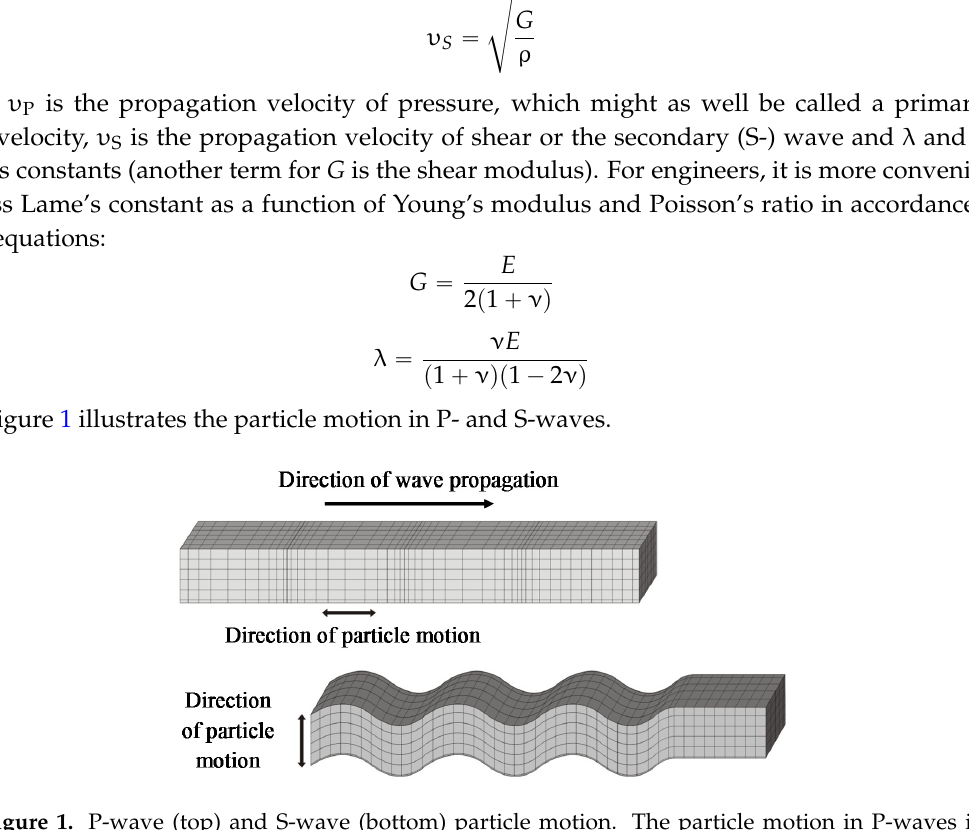
Figure 1. P-wave (top) and S-wave (bottom) particle motion. The particle motion in P-waves is longitudinal, while in S-waves, it is transverse. The particle motion vector in the plane perpendicular to the direction of propagation is referred to as polarization (only in the case of S-waves) [8]. Over the years, bender elements have become increasingly popular in order to determine the S-wave velocity [9,10] through experiments. Nowadays, they are commonly available [11,12]. Bender elements consist of two sheets produced from piezoceramic plates, which are rigidly bonded, to a center brass shim or stainless steel plate. Because of their piezoelectric properties, they are capable of converting mechanical excitation into electrical output and vice versa . When excited by an